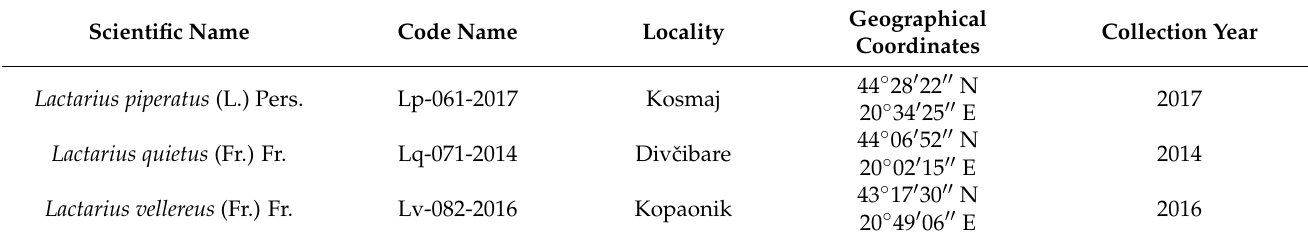
Table 1. Identified Lactarius